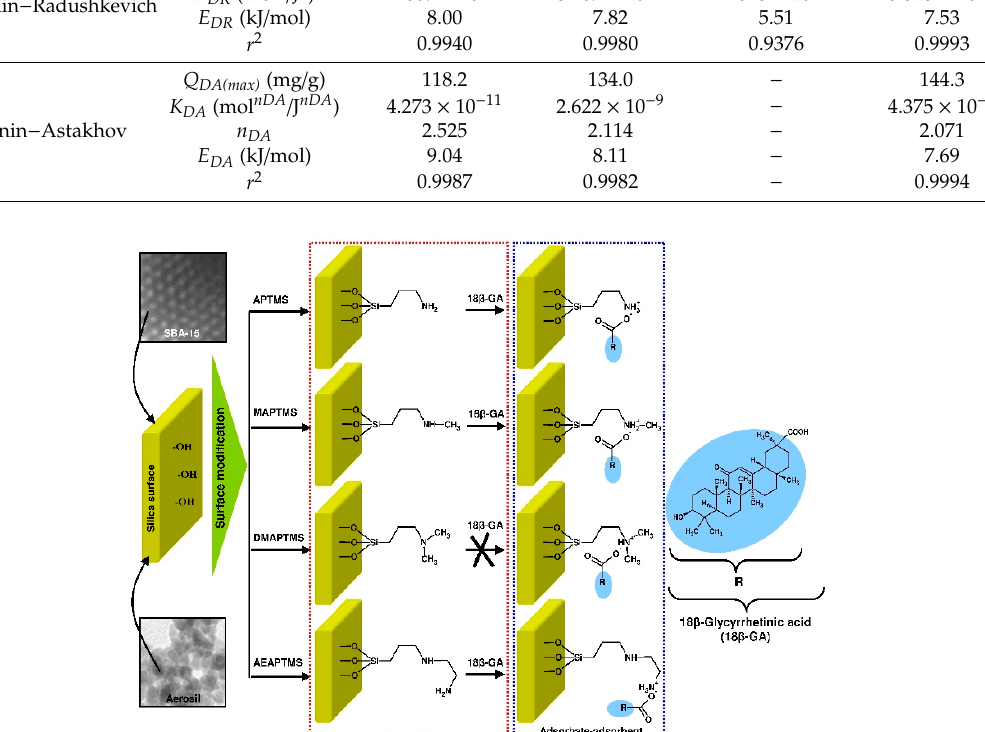
Figure 9. The scheme presenting interactions between 18 β -glycyrrhetinic acid and aminopropyl- derivative-modified siliceous surface.